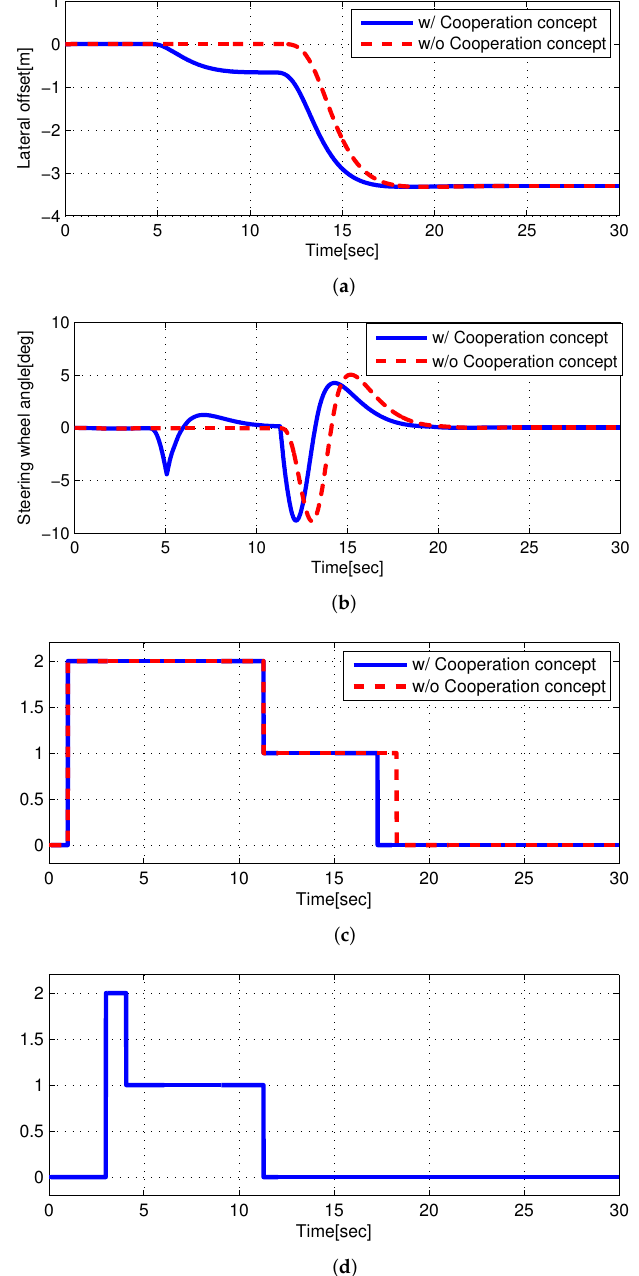
Figure 8. Simulation Results of case 1. ( a ) Lateral offset (to the center line of the original lane) of the ego vehicle. ( b ) Steering wheel angle of the ego vehicle. ( c ) Collision risk. 1: safe; 2: danger. ( d ) Cooperation index of method 2. 1: CD; 2: